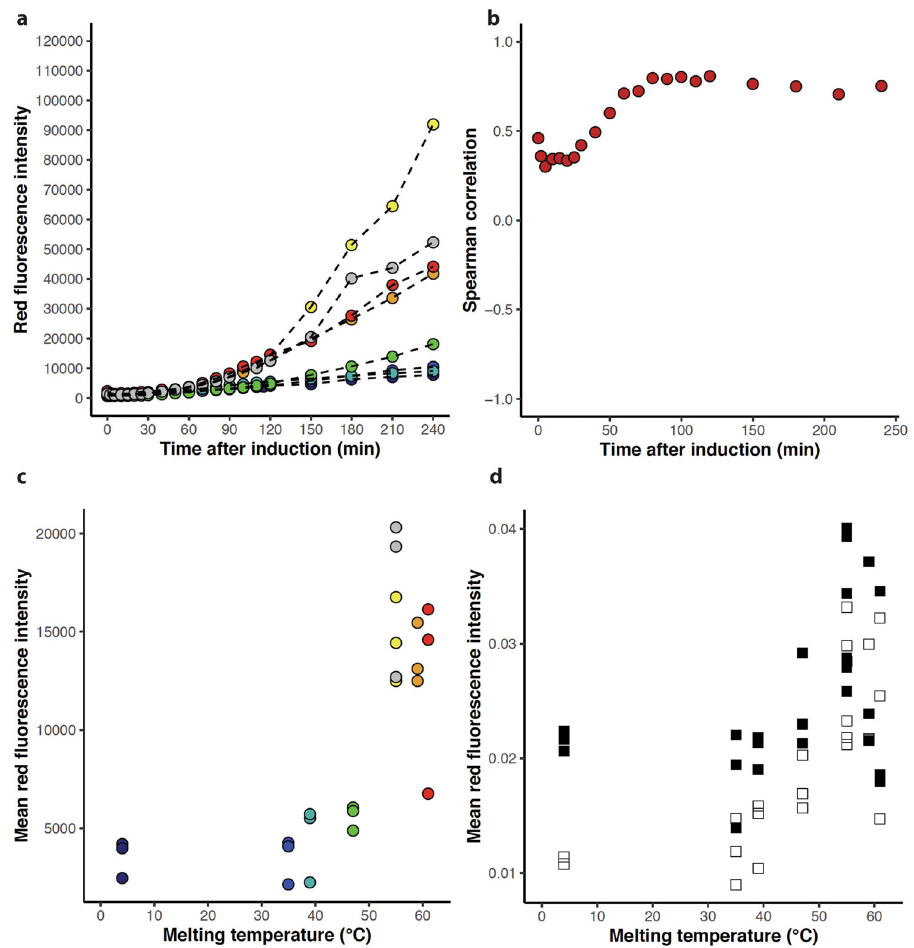
Fig. 3 Abundance of tagRFP fusion proteins monitored by red fl uorescence. a Mean red fl uorescence intensity of cells expressing variants: L57G (dark blue), L57C (blue), L57P (cyan), M40A (green), Q33S (yellow), V36I (orange), Q33Y (red) and wt (grey). One of three replicates are shown for each variant. b Spearman correlation between mean red fl uorescence and variant melting temperature at each time point. Calculations are based on three replicates of each variant. c Mean red fl uorescence intensity at the 120 min time point for the eight N102LT variants with different melting temperature. Spearman correlation = 0.81. Colour scheme as in ( a ). d Early (30 – 60 min, black) and late (60 – 90 min, white) relative rates of red fl uorescence calculated for the eight N102LT variants with different melting temperature. Spearman correlation between early rate and variant melting temperature is 0.33. Spearman correlation between late rates and variant melting temperature is